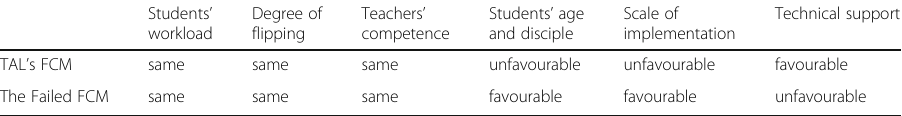
Table 4 Similar and different factors in implementing